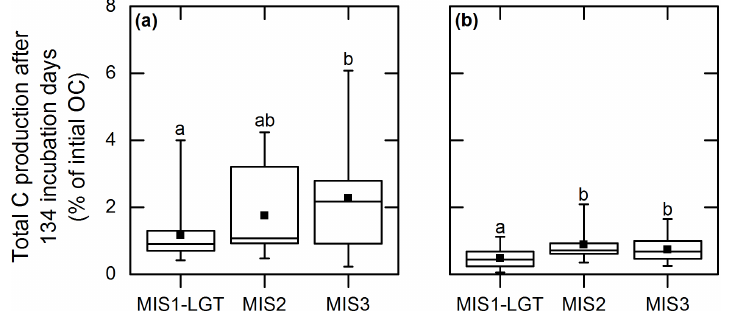
Figure 6. Total aerobic (a) and anaerobic (b) CO 2 -C production after 134 incubation days from permafrost deposits from the MUO12 sequence, the BK8 core, and the two L14 cores from the Holocene interglacial (MIS 1), including the late glacial transition (LGT) ( n = 22), the Sartan stadial (MIS 2) ( n = 15), and the Kargin interstadial (MIS 3) ( n = 50). The whiskers show the data range and the box indicates the interquartile range. The vertical line and square inside the boxes show the median and mean, respectively. The different letters indicate significant differences (Mann–Whitney test, p< 0 . 016) between deposits from different